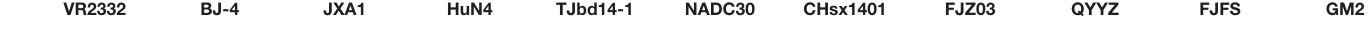
TABLE 2 | Sequence distance of four isolates in this study with reference